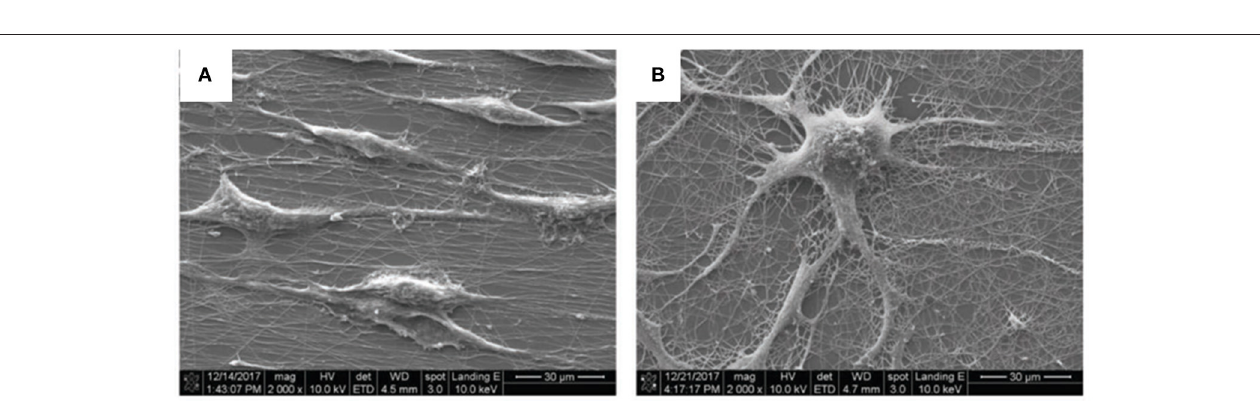
FIGURE 6 | Scheme of PEDOT electrochemical deposition around the neural cell monolayer on the electrode surface. Adapted from (83) with permission from the publisher.